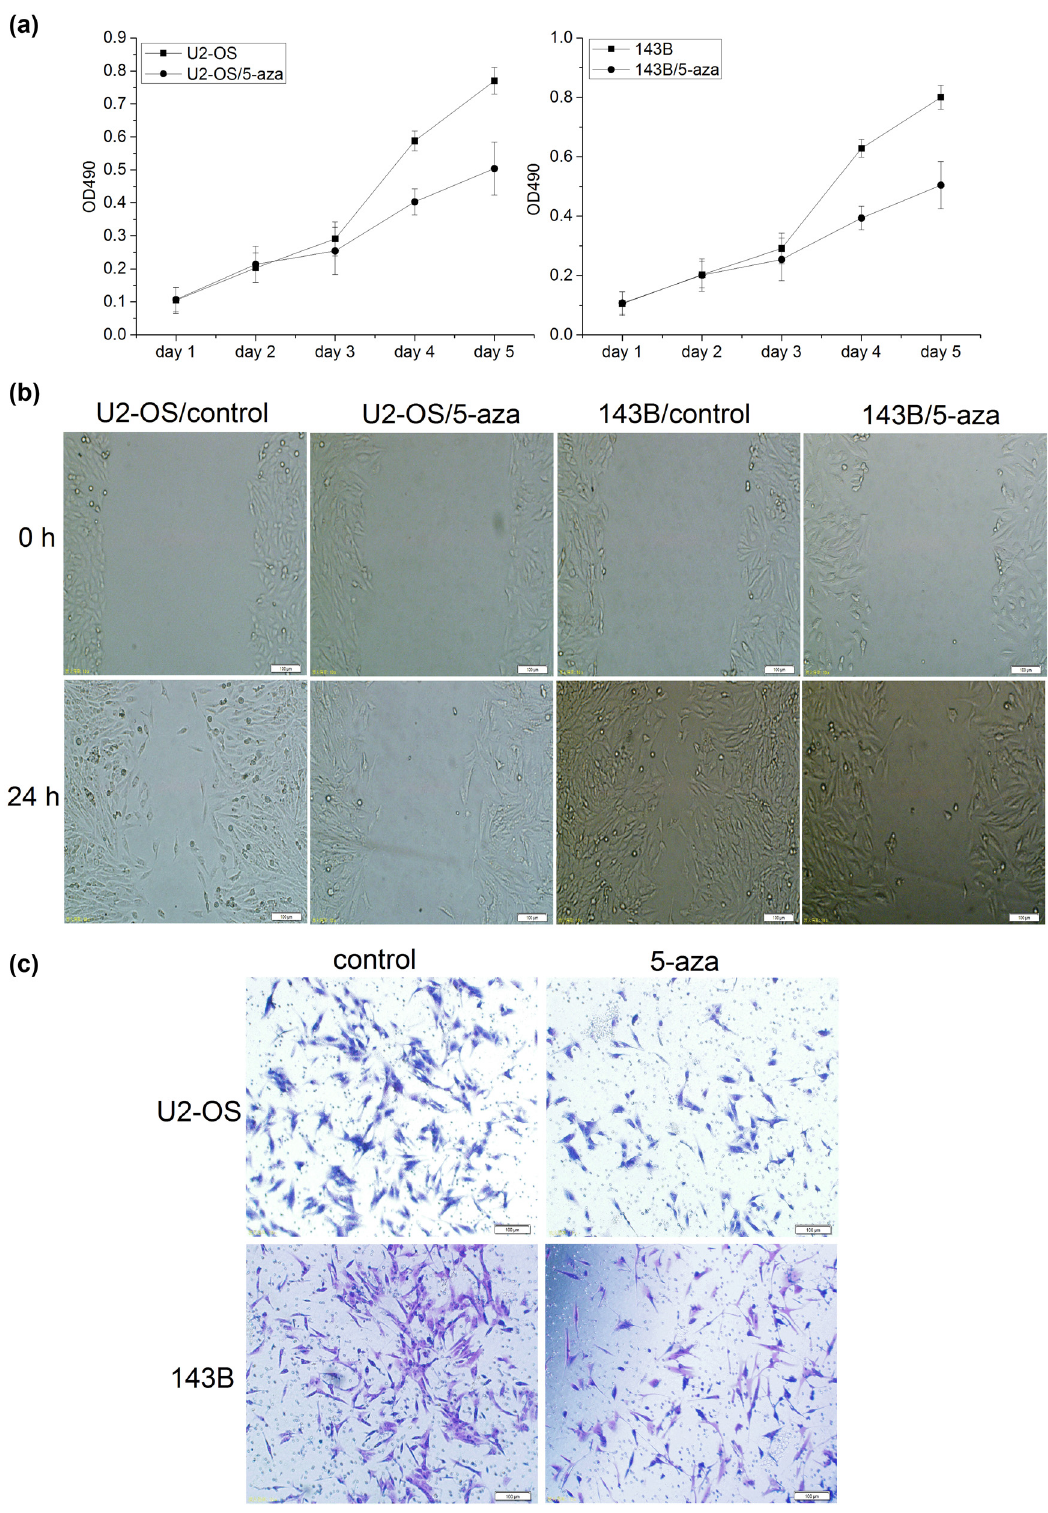
Figure 5: Methylation might promote osteosarcoma cell proliferation, migration, and invasion. ( a ) The proliferation activity of osteosarcoma cells was detected by MTT assay. MTT assay showed that the proliferation was signi fi cantly decreased in U2 - OS and 143B cells treated with 5 - aza - 2 ′ - dc ( n = 6, day 4: p < 0.001 ) . The error bar represents the standard variation of the OD490 in the U2 - OS or 143B cells treated with 5 - aza. ( b ) The migration ability of osteosarcoma cells at 24 h was signi fi cantly decreased in the cells treated with 5 - aza - 2 ′ - dc ( n = 6, × 200 ) . ( c ) The invasion ability of osteosarcoma cells at 24 h was signi fi cantly decreased in the cells treated with 5 - aza - 2 ′ - dc ( n = 6, × 200 )